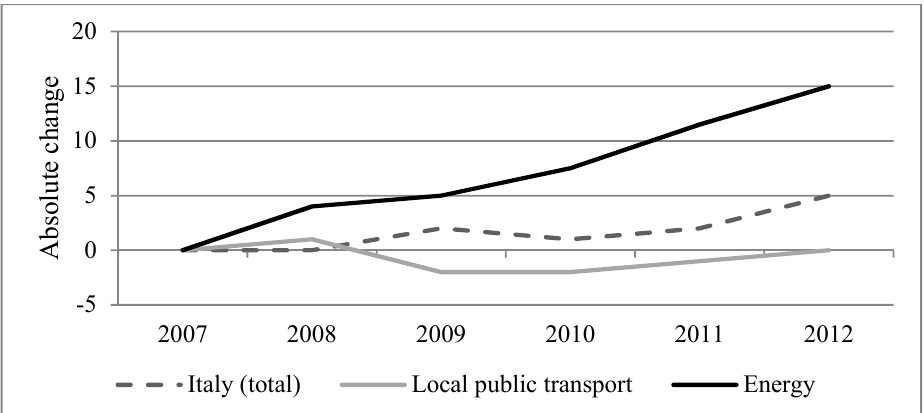
Graph 2: IBL Liberalisation Index – focus on Energy and